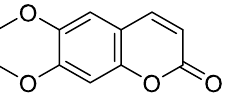
Figure 9. Chemical structures of scoparone (6,7-dimethoxy coumarin).